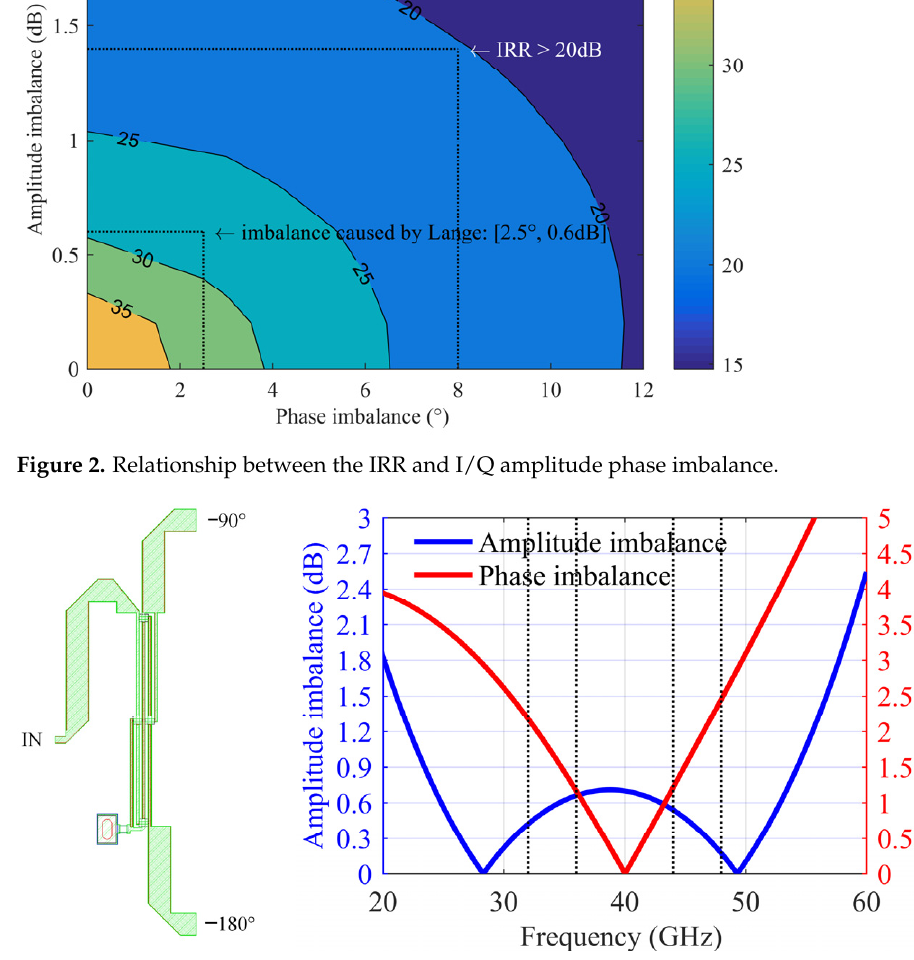
Figure 3. ( a ) Lange coupler simulation model; ( b ) Simulation results.